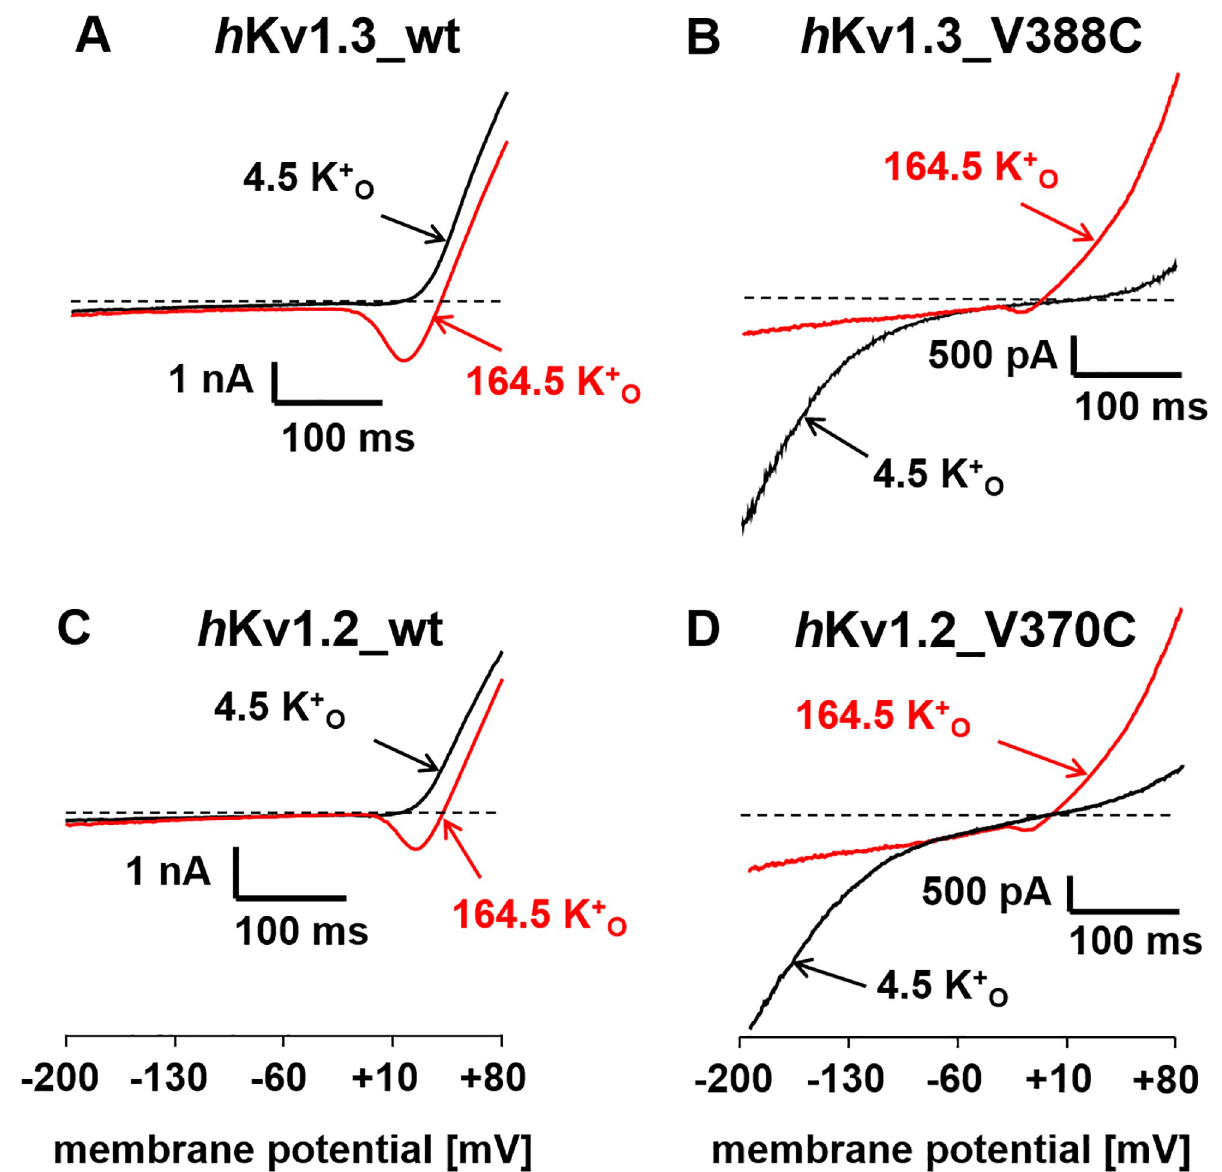
Fig 1. h Kv1.2_V370C mutant channels promote an inward current at potentials more negative than -100 mV, similar to h Kv1.3_V388C mutant channels. Ramp currents through h Kv1.3_wt( A ), h Kv1.3_V388C( B ), h Kv1.2_wt( C ) and h Kv1.2_V370C ( D ) mutant channels in [160 Na + + 4.5 K] o (black traces) and [164.5 K + ] o (red traces) externalbath solution.The currents were elicited by 400-ms voltageramps from -200 to +80 mV every 30 s from a holding potentialof -80 mV.